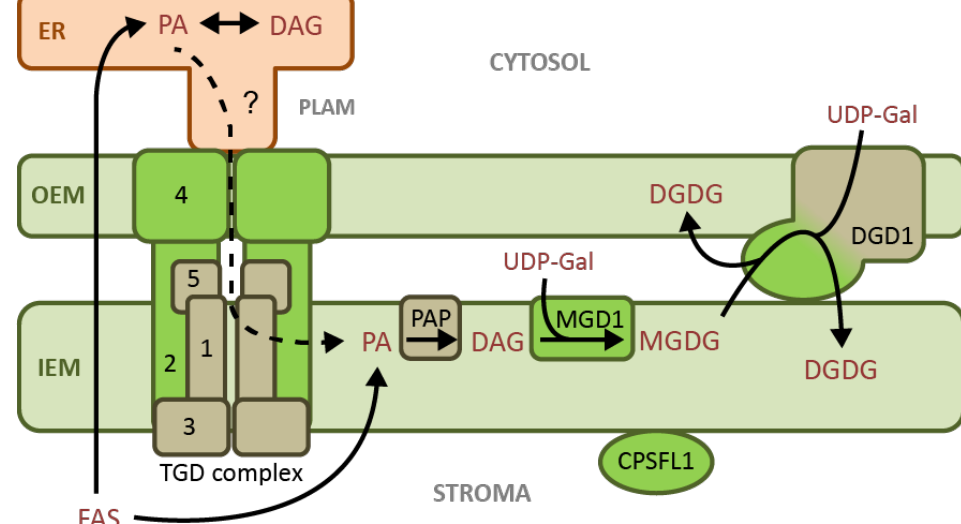
Figure 1. Roles of phosphatidic acid (PA) in chloroplast lipid metabolism. Proteins colored in green have specific interactions with PA, which may serve as a regulator, substrate, or both. The potential role of PA as the substrate for lipid import into the chloroplast is represented by a dotted arrow and a question mark, as this remains uncertain. List of abbreviations in alphabetical order: CPSFL1, CHLOROPLAST SEC14-LIKE1 protein; DAG, diacylglycerol; DGD1, UDP-galactose:MGDG galactosyltransferase; DGDG, digalactosyldiacylglycerol; ER, endoplasmic reticulum; FAS, Fatty acid synthase; MGD1,monogalactosyldiacylglycerol synthase; MGDG, monogalactosyldiacylglycerol; PA, phosphatidic acid; PAP, phosphatidic acid phosphatase; PLAM, plastid associated microsomes; TGD complex, trigalactosyldiacylglycerol complex; UDP-Gal, uridine diphosphate-galactose. The numbers refer to the TGD1-5 proteins forming the TGD